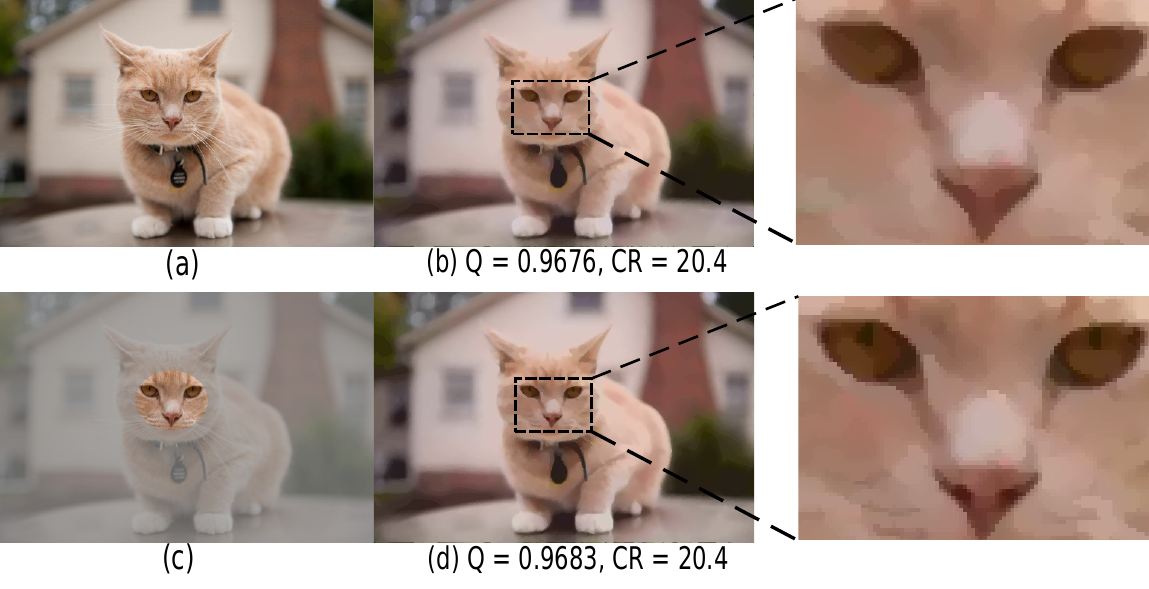
Figure 19. The benefits of handling salient information. ( a ) Input image. (512 × 337) ( b ) The SDMD reconstruction with the enlarged area of the face on the right. ( c ) The manually set salient area. ( d ) The SDMD reconstruction considering salient